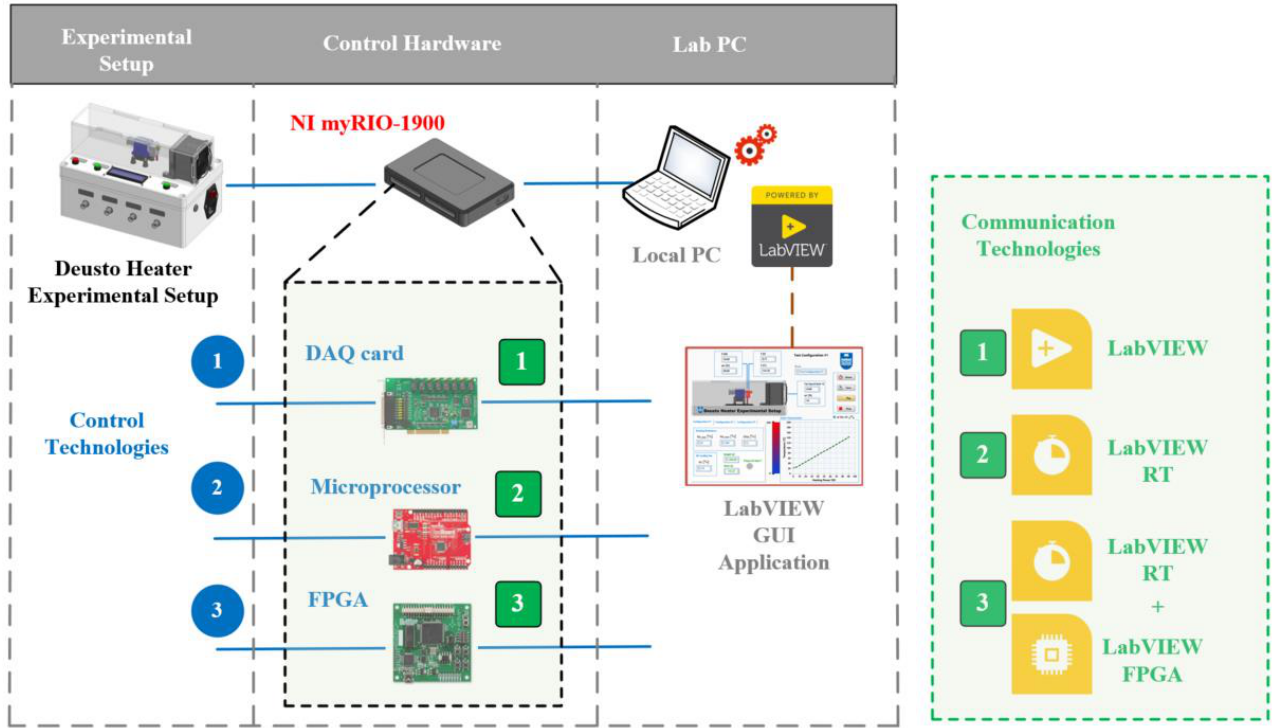
Figure 27. Scheme of the hardware architecture used for operation and implementation of fractional-order model identification algorithms applied to the laboratory prototype.